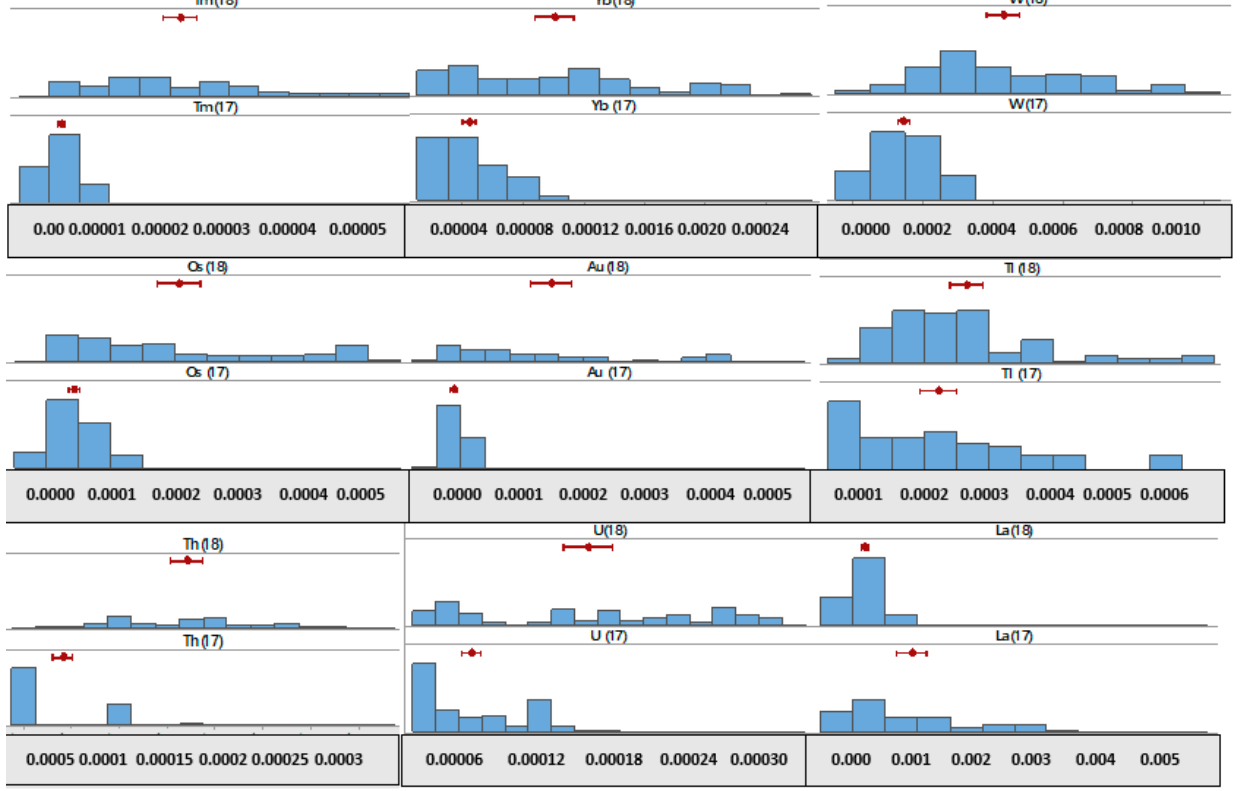
Figure 9. Annual fluctuation of mineral concentrations for the wine samples.